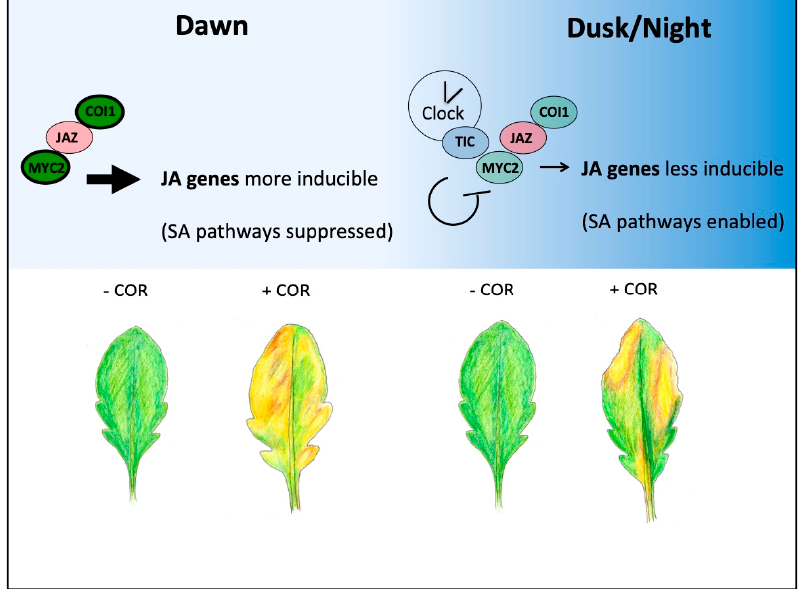
Figure 2. Gating of JA responses through gene expression control and by TIC. COI1-JAZ-MYC signaling complex positive components (green) and negative components (red) are shown in the morning (left) or evening (right); more intense coloring and darker border indicate higher protein abundance. Throughout the night and at dawn, the clock protein TIC reduces MYC2 protein abundance likely through direct interaction, and it therefore restricts MYC2-dependent actions (right side) [76]. Positive factors of the COI1-JAZ-MYC2 complex (COI1, MYC2) are more abundant at dawn and during the daytime due to transcriptional or post-translational control, and this is one mechanism that gates JA responsiveness to this time of the day. JA early genes (i.e., JAZ5 ) are most inducible by JA treatment at dawn [76]. The JA mimic coronatine (COR) produced by Pseudomonas syringae ( Pst DC3000) hyper-activates the JA pathway and suppresses SA-dependent and independent host defenses against biotrophic pathogens [77,78]. Treatment of plants at dawn with Pst DC3000 results in leaves that support more pathogen proliferation compared to treatment at dusk, although clock-timing of stomata closure that is independent of JA signaling could play an important role too (bottom) [76,79].